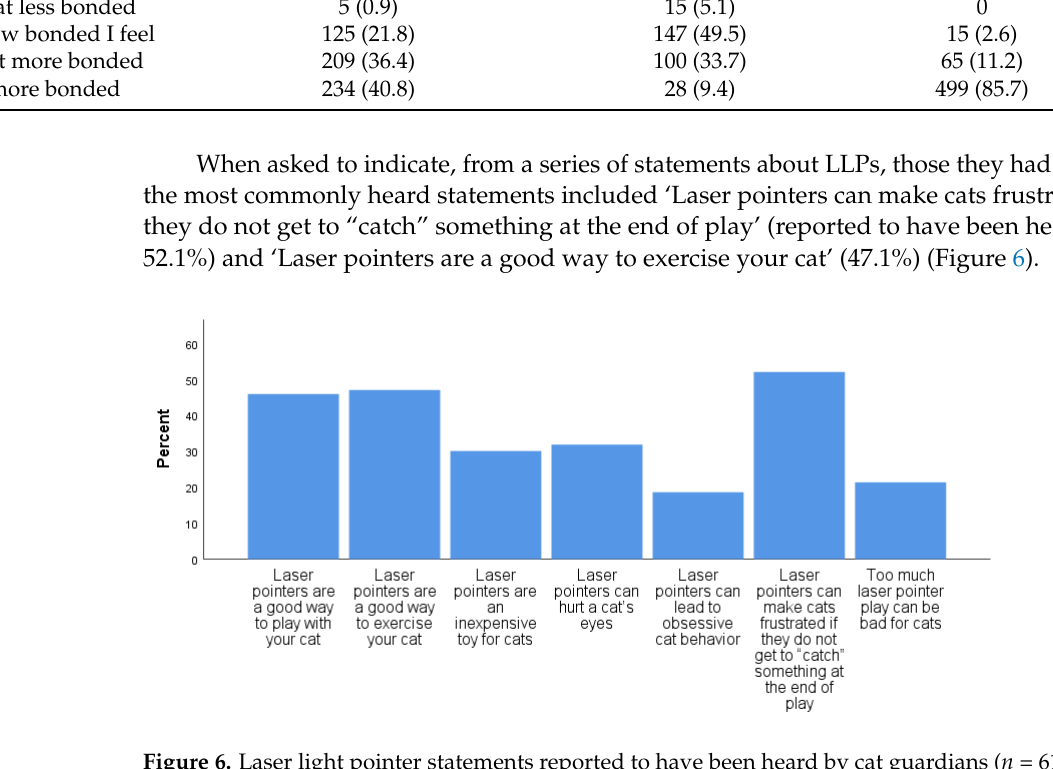
Figure 6. Laser light pointer statements reported to have been heard by cat guardians ( n = 618).